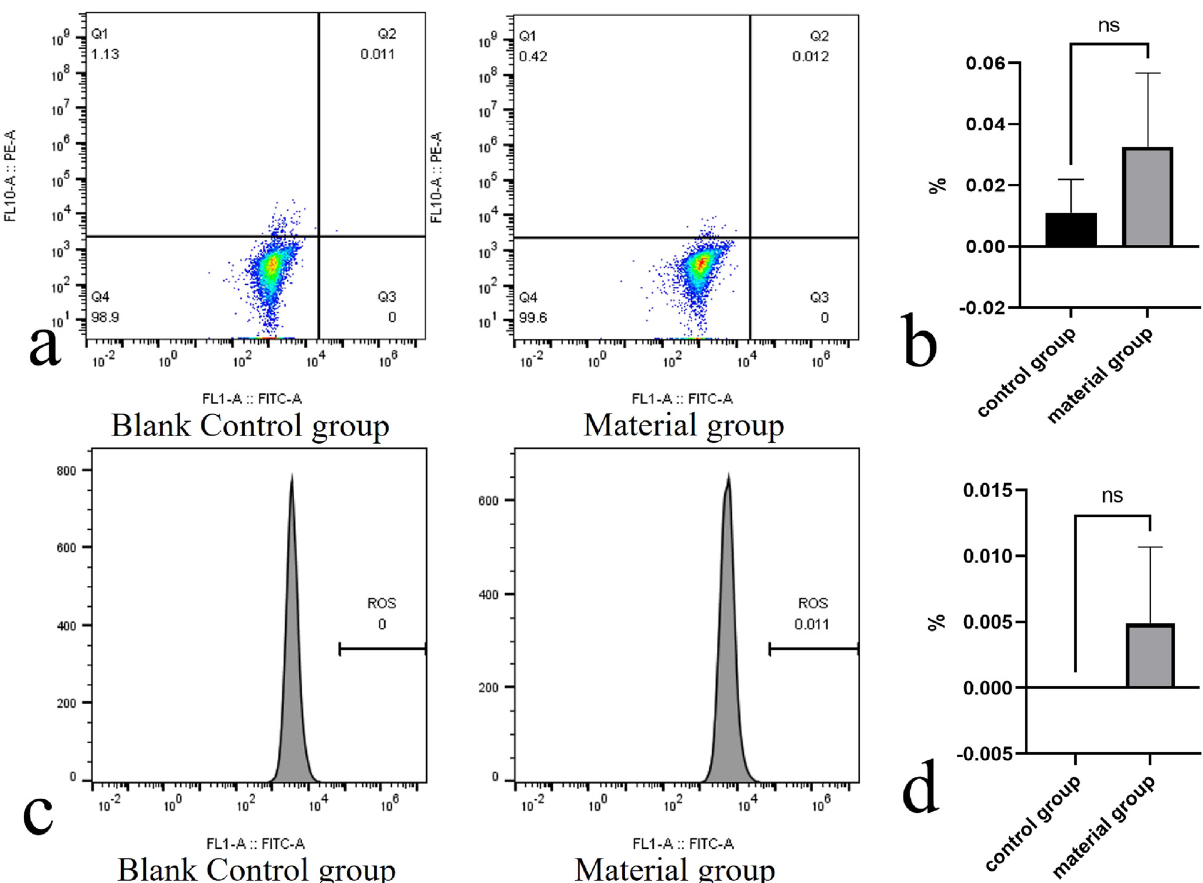
Figure 9: ( a and b ) Comparison of cell apoptosis between material group and blank control group ( p > 0.05 ) ; ( c and d ) comparison of ROS level between material group and blank control group ( p > 0.05 )